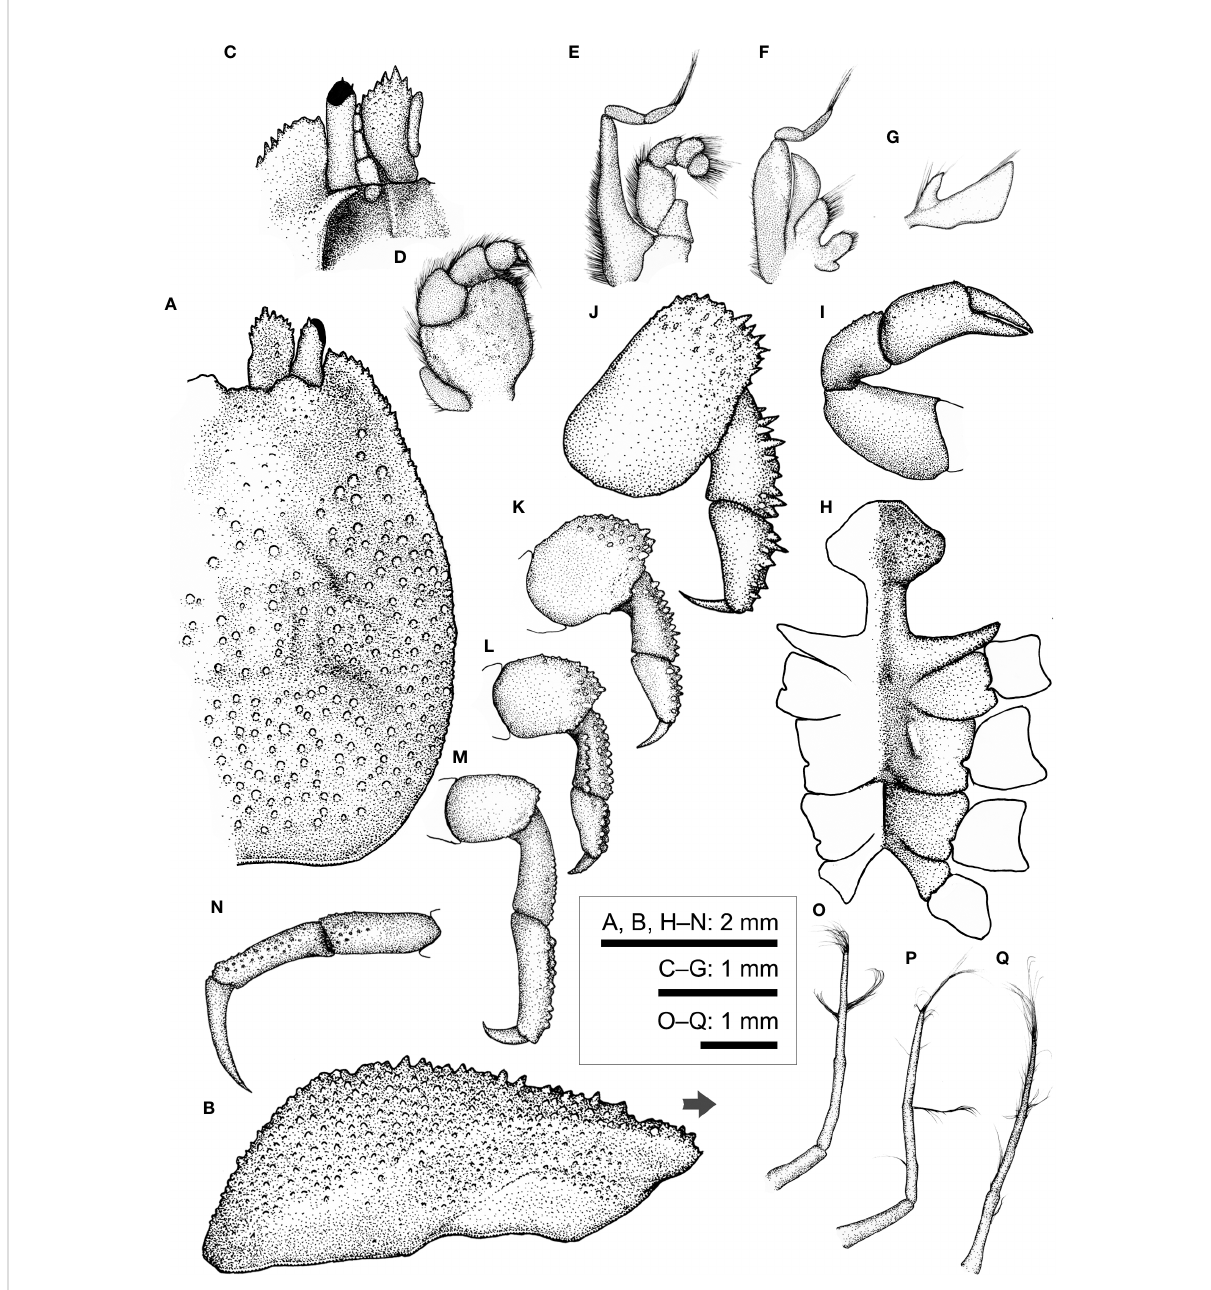
FIGURE 12 Lithposcaptus scottae sp. nov., female (CEL-Hapa-019). (A) carapace, dorsal view; (B) carapace, lateral view; (C) anterior view of carapace, ventral view; (D) right Mxp3; (E) right Mxp2; (F) right Mxp1; (G) right Mxl 1; (H) thoracic sternites; (I) right P1; (J – M) right P2 to P5, dorsal view; (N) right P5, propodus and dactylus, lateral view; (O – Q) Plp1 to Plp3. Arrow in (B) indicates the anterior